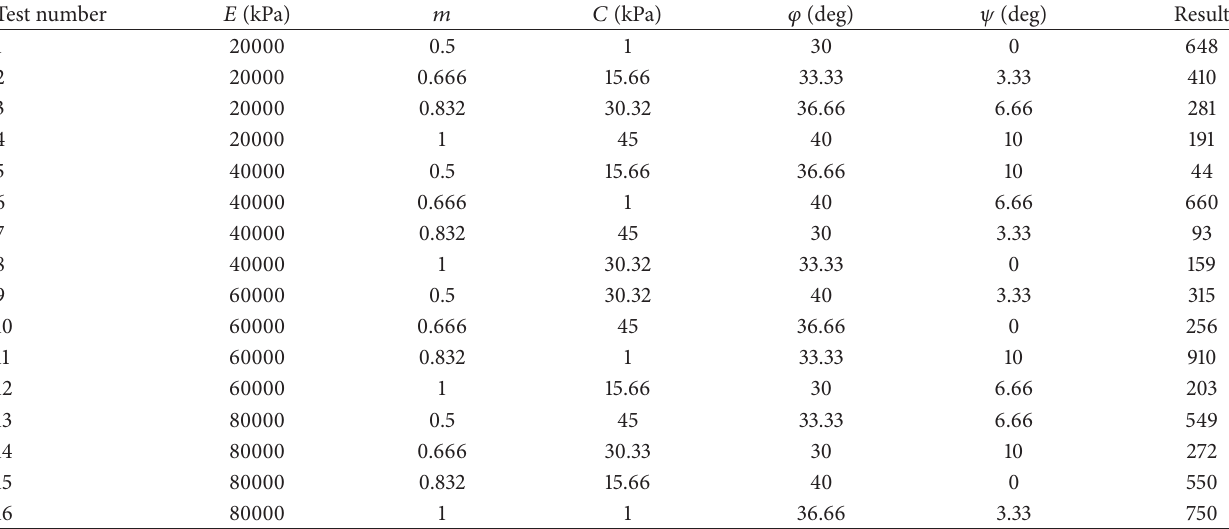
Table 6: Final plan of experiments for this project.